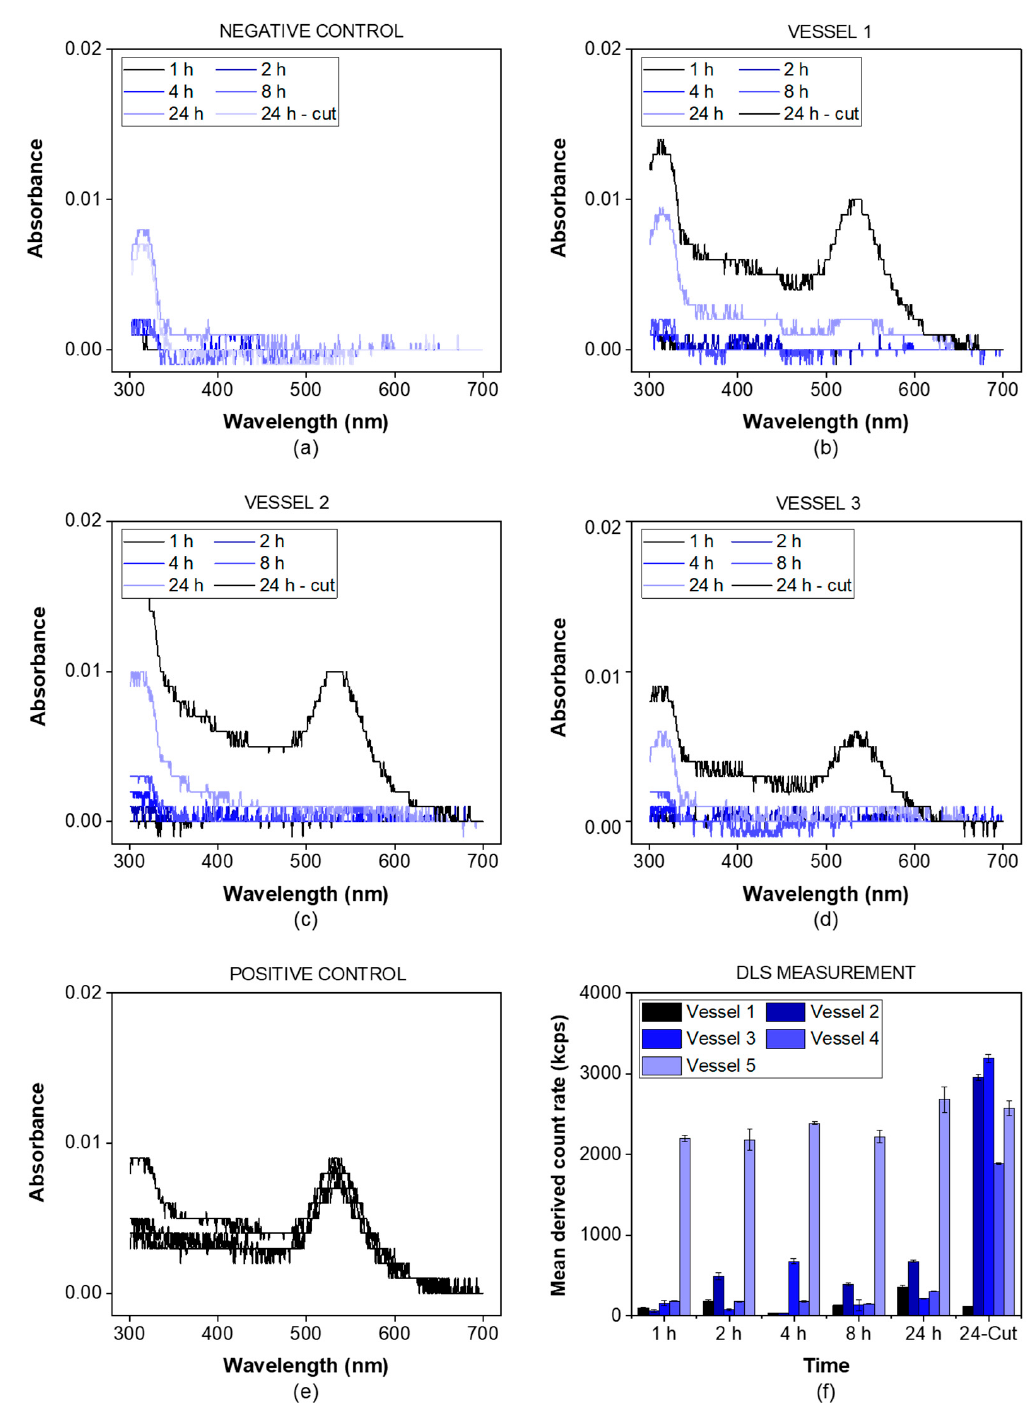
Figure 3. Membrane integrity test using a dispersion of gold nanoparticles ( λ max = 535 nm). The samples were analyzed by UV-VIS spectrophotometry at a wavelength of 300–700 nm. The negative control was measured without adding gold nanoparticles ( a ) while the positive control involved an incision through the membrane before starting the experiment ( e ). For all other vessels ( b – d ), the gold nanoparticles were added to the vessel and the spectrum was recorded at the indicated time points. After 24 h, a small incision through the membrane was performed. The spectra indicating the presence of gold nanoparticles in the acceptor compartment were highlighted in black for all vessels. Additionally, the mean derived count rate in the acceptor compartment was measured indicating the presence of gold nanoparticles in all vessels after the incision but not before this time point, except for the positive control ( f ).